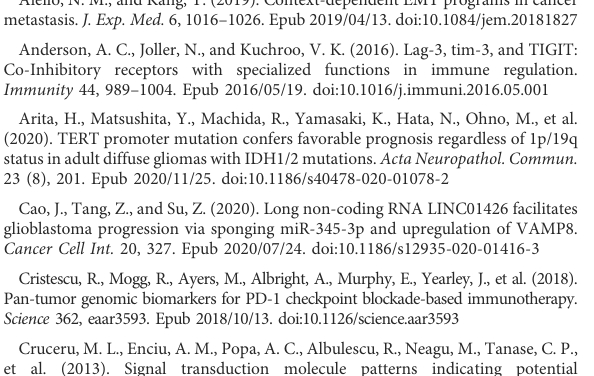
SUPPLEMENTARY TABLE S1 The details of all of the ferroptosis-related genes. SUPPLEMENTARY TABLE S2 The table of differentially expressed lncRNAs and ferroptosis-related lncRNAs. SUPPLEMENTARY TABLE S3 The list of pathways enriched in